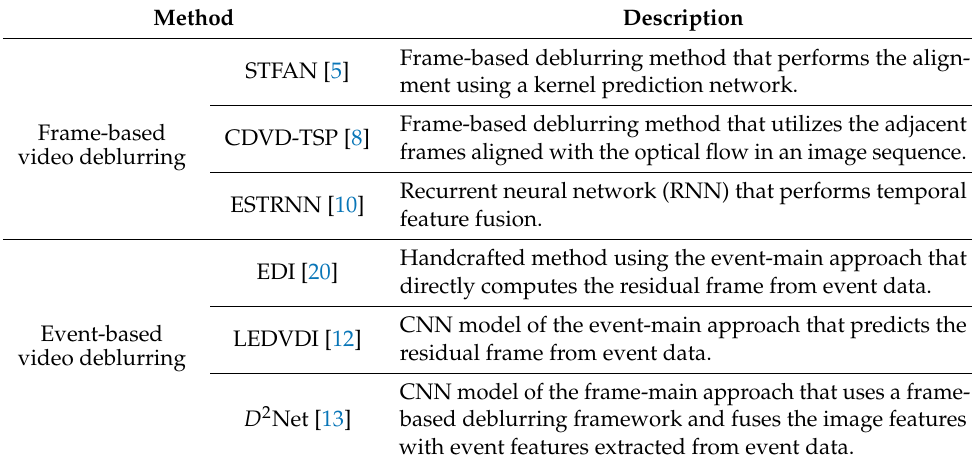
Table 1. Summary of related works on video